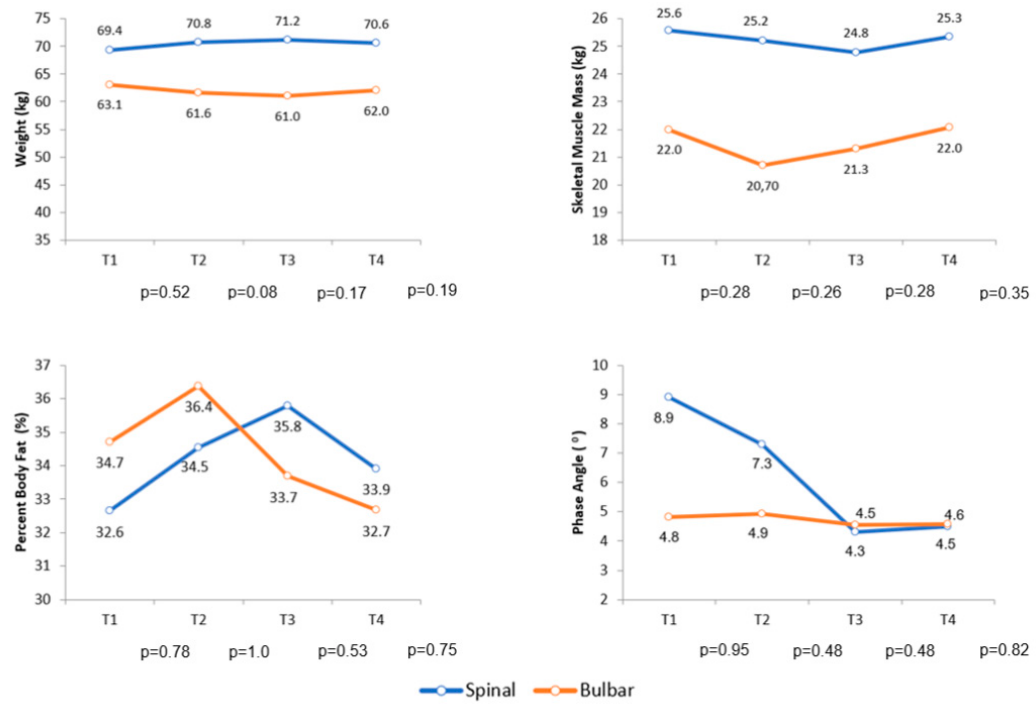
Figure 3. Average variation in body weight, skeletal muscle mass, percent body fat and phase angle during follow-up. Abbreviations: T (Follow-up time).